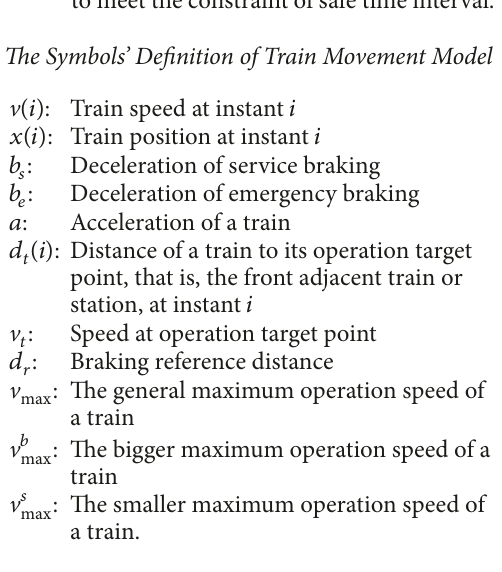
𝑀 𝑘 : The number of arrival-departure tracks